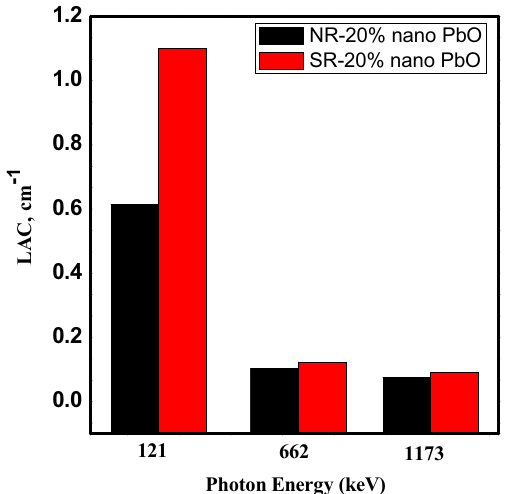
Figure 14. Comparison the LAC between our result for 20 wt% of nano-PbO/Silicon Rubber and 20 wt% of nano-PbO/Natural RUBBER at 121.8, 661 and 1173.2